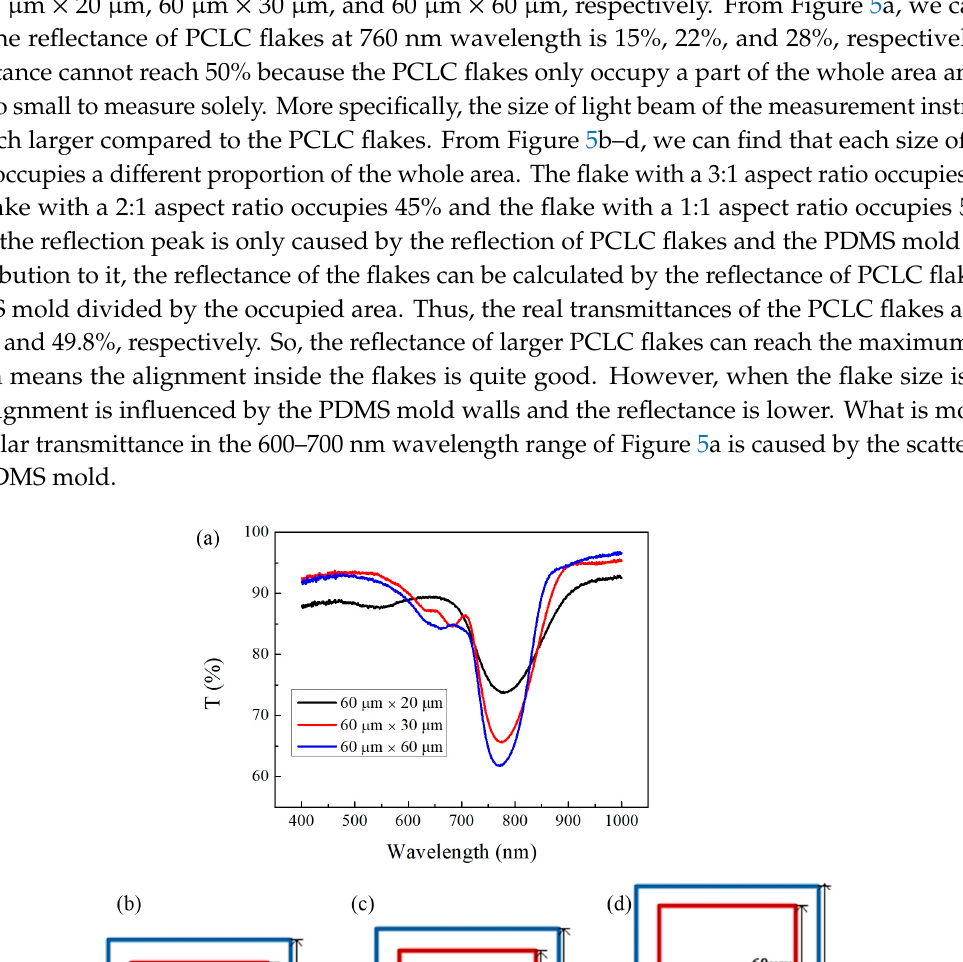
Figure 4. Characterization of flakes: ( a ) POM image of PCLC flakes in a PDMS mold; ( b ) The topography of PCLC flakes in PDMS mold; ( c ) the width of a single PCLC flake; ( d ) the height of a single PCLC flake.